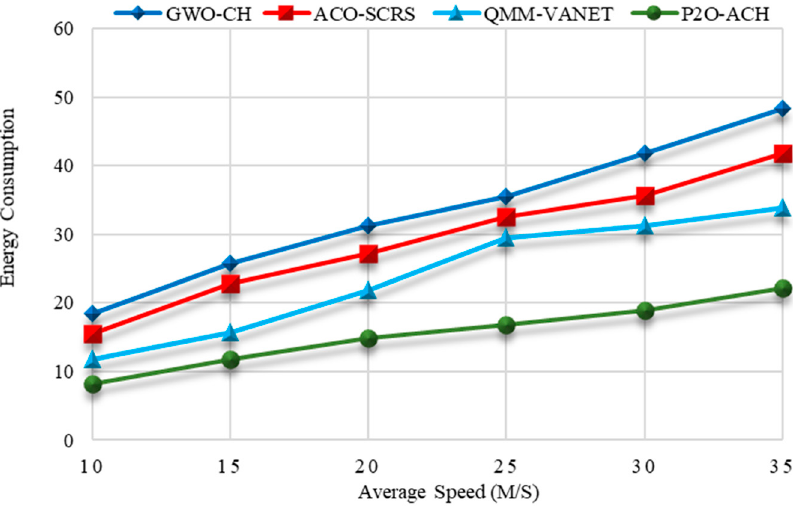
Figure 11. Energy Consumption Calculation.